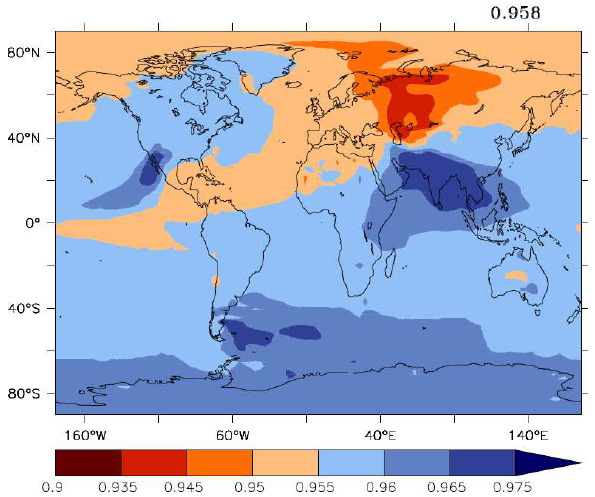
Fig. 15. Single scattering albedo of airborne